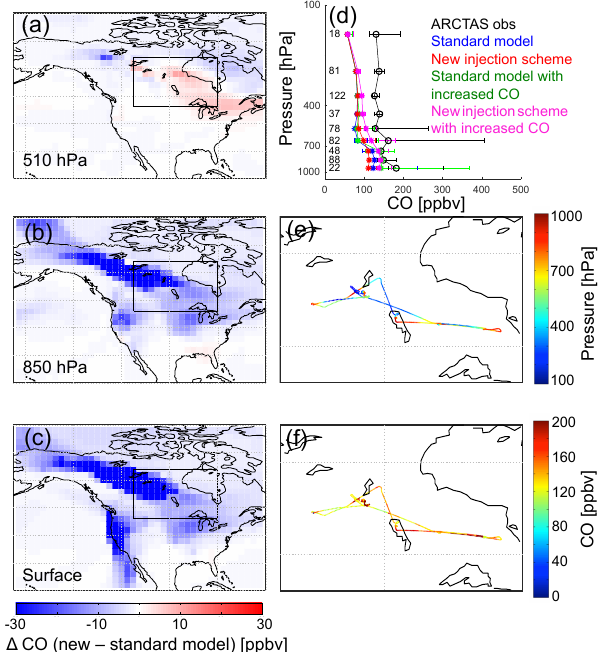
Figure 6. Same as Fig. 4 but for 4 July 2008.